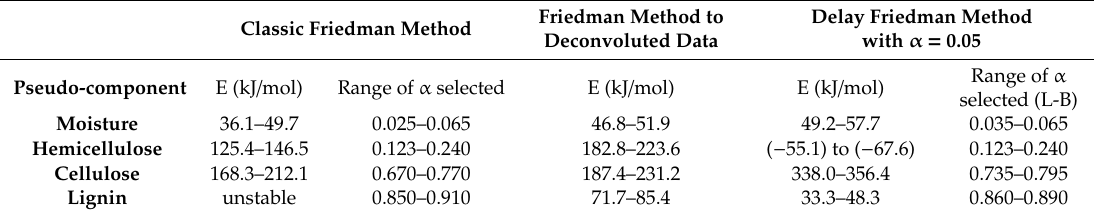
Table 5. Ranges of α and E values obtained for each